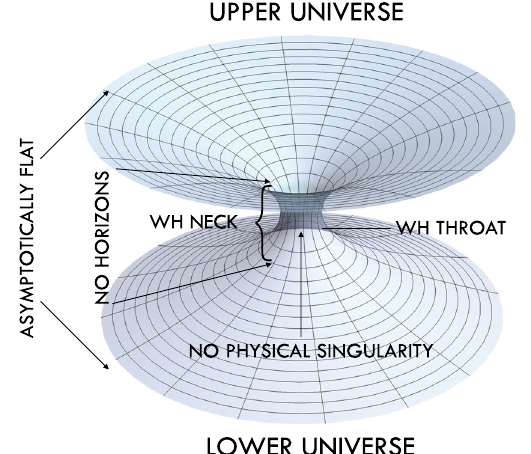
Fig. 1 Sketch of WH geometry